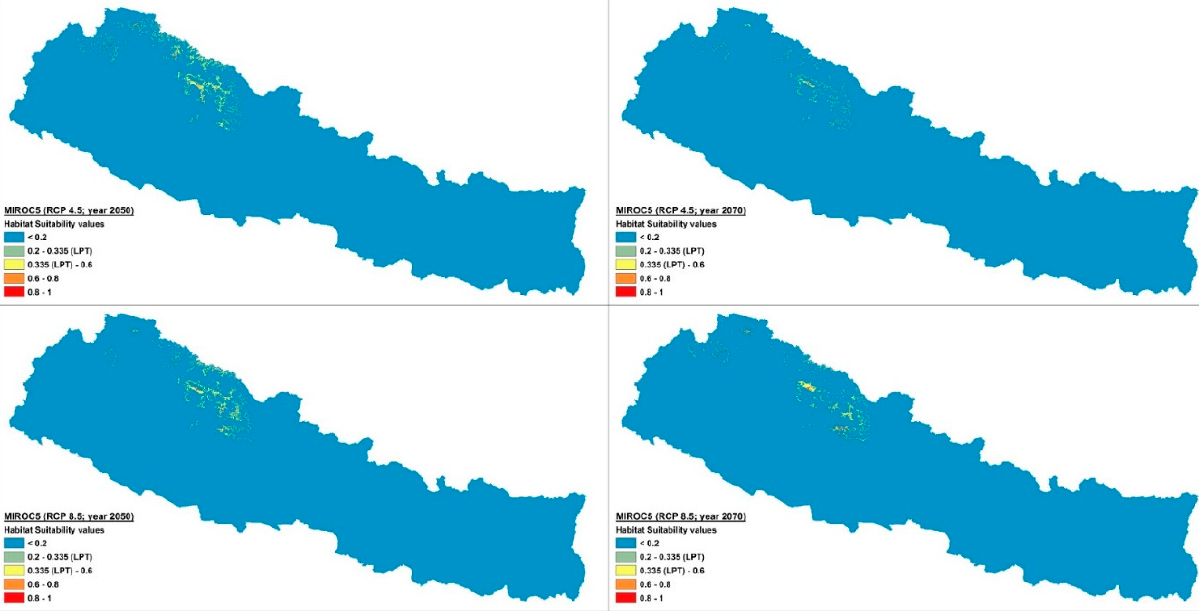
Figure 5. Climate change scenario under MIROC5 model, RCP 4.5 and 8.5 at 2050 and 2070.